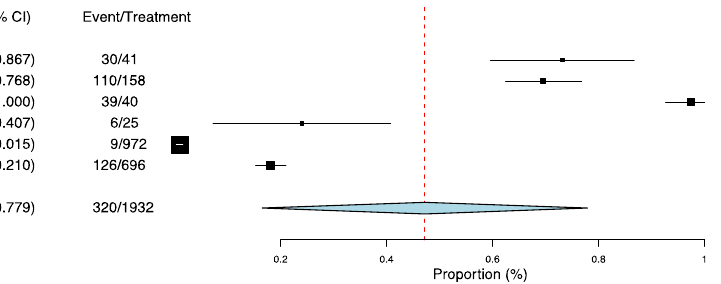
Figure 2. Incidence rate of dry eye among individuals with allergic conjunctivitis.